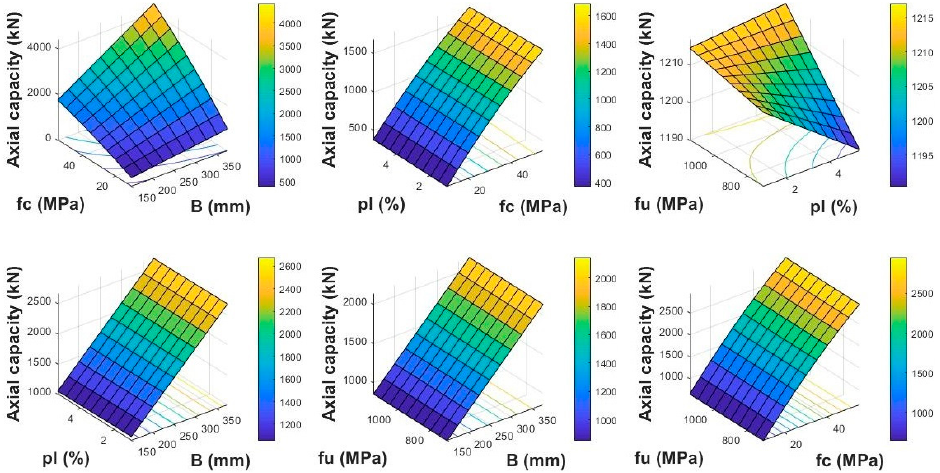
Figure 13. Detailed parametric investigation using